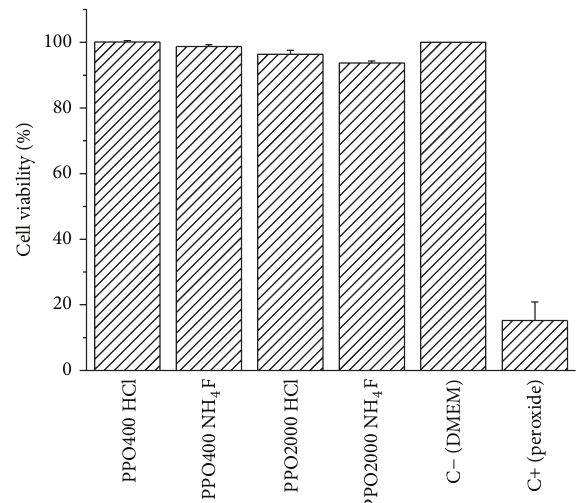
Figure 2: Cytotoxicity assay with human skin keratinocytes cells for ureasil-PPO. Results are expressed as the mean ± SD of triplicates ( 𝑛 = 3 ).